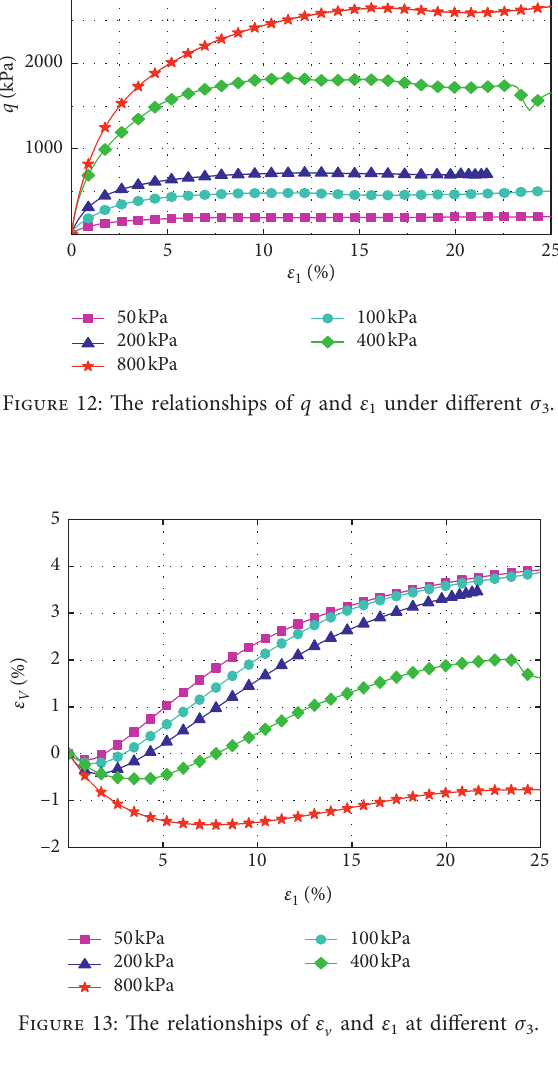
v and ε 1 at different σ 3 .